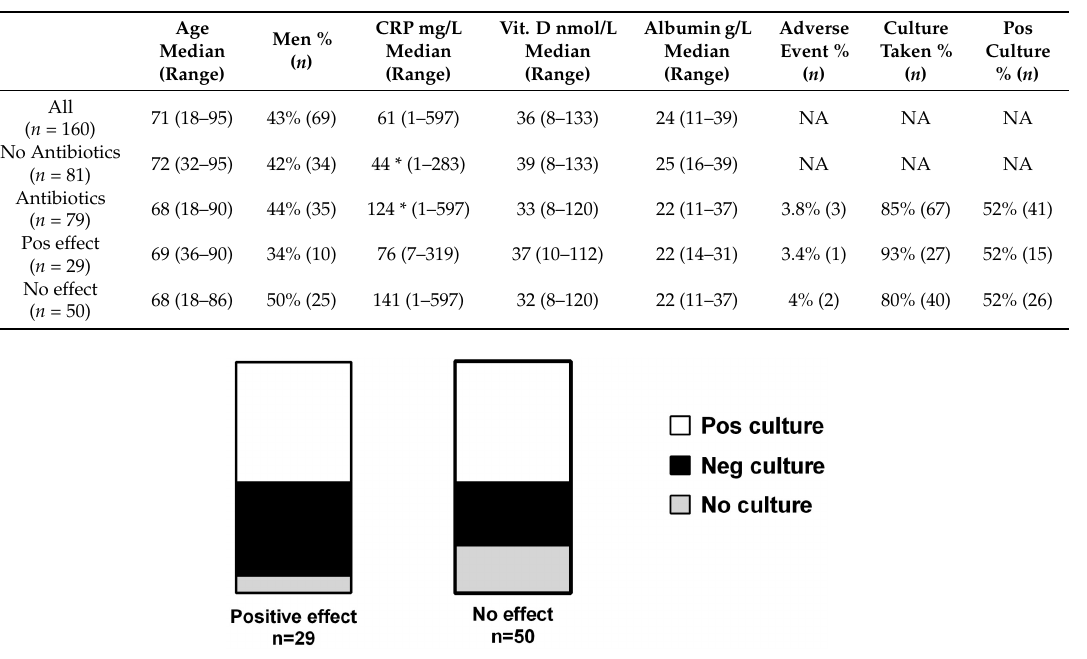
Figure 2. Distribution of number of positive and negative cultures among end ‐ of ‐ life cancer patients in patients who had positive (Pos effect) or unknown/no effect (No effect) of antibiotic treatment. There was no statistically significant difference between the distribution of positive and negative cultures between the groups (Chi 2 -test, p =